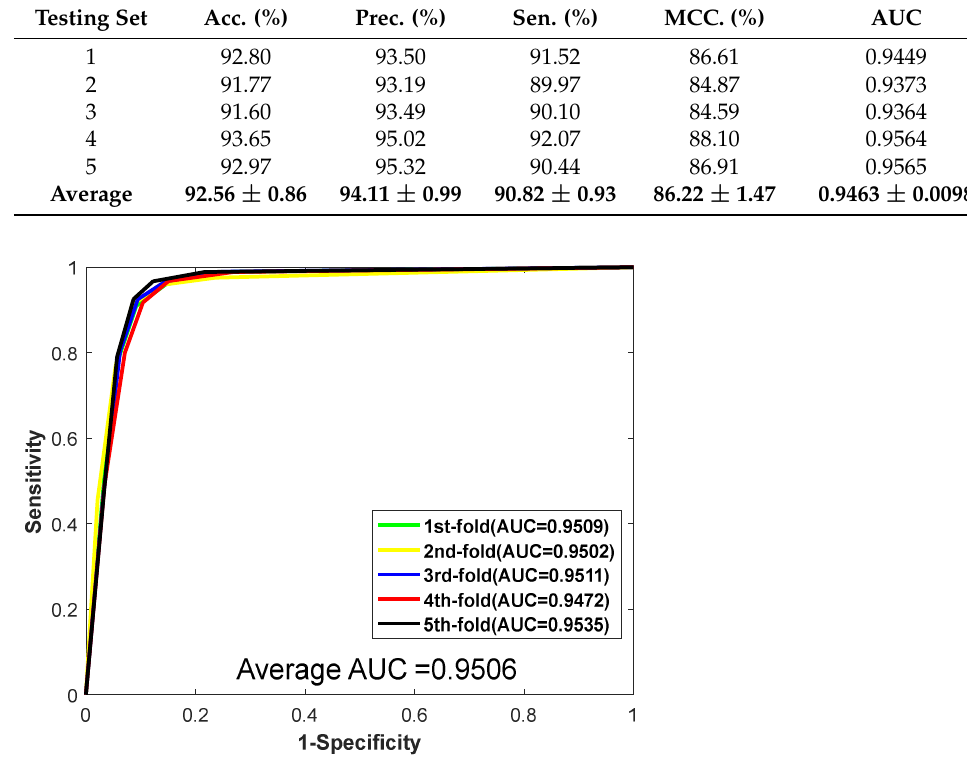
Figure 2. ROC curves yielded by RF on Yeast .